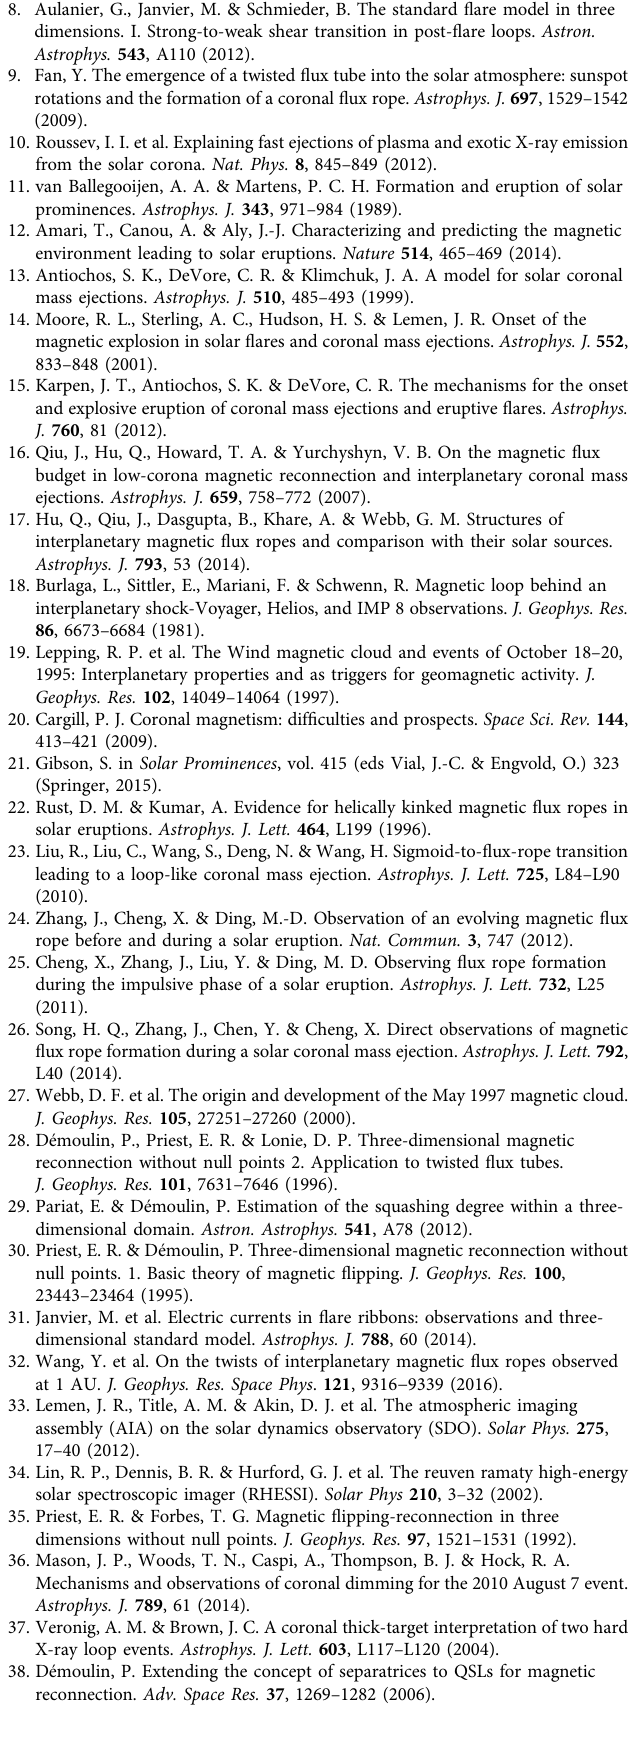
Fig. 4k represents a fl ux surface enclosing the core structure corresponding to A > A b , where the model assumptions, two-dimensionality and quasi-static equilibrium, are deemed well satis fi ed based on the fi tting. The solution exhibits a typical MFR structure with nested fl ux surfaces of monotonically decreasing axial fi eld from the center (Fig. 4k). Within the fl ux surfaces fi eld lines wind around the axis z in a right-handed sense. Various physical quantities can be derived from the GS reconstruction results 16, 17, 65 . In particular, the toroidal (axial) and poloidal fl ux, all evaluated for the volume within the boundary A = A b , are 0.919 ×10 21 Mx and 1.754 ×10 21 Mx (per AU), respectively. Assuming the same range for the MC ’ s axial length as in the force-free fi ttings above, we estimate the total poloidal fl ux (4.509 ± 1.002)×10 21 Mx. A similar range, 2 – 4AU 65 , has been obtained by comparing the GS reconstruction with the lengths of magnetic fi eld lines derived from in situ energetic electrons. Both poloidal and toroidal fl uxes are roughly the same as those derived by the force-free fi ttings, and comparable to those derived from solar observations in orders of magnitude (Supplementary Table 1). The twist of a fi eld line τ ( A ) is given by